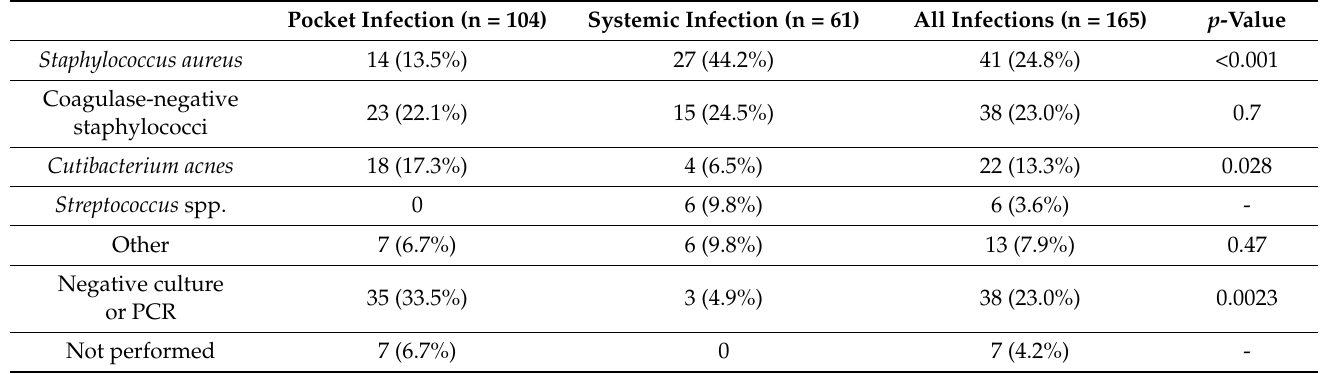
Table 4. Microbiological findings in 165 patients with CIED removal due to infection. Pocket Infection (n = 104)